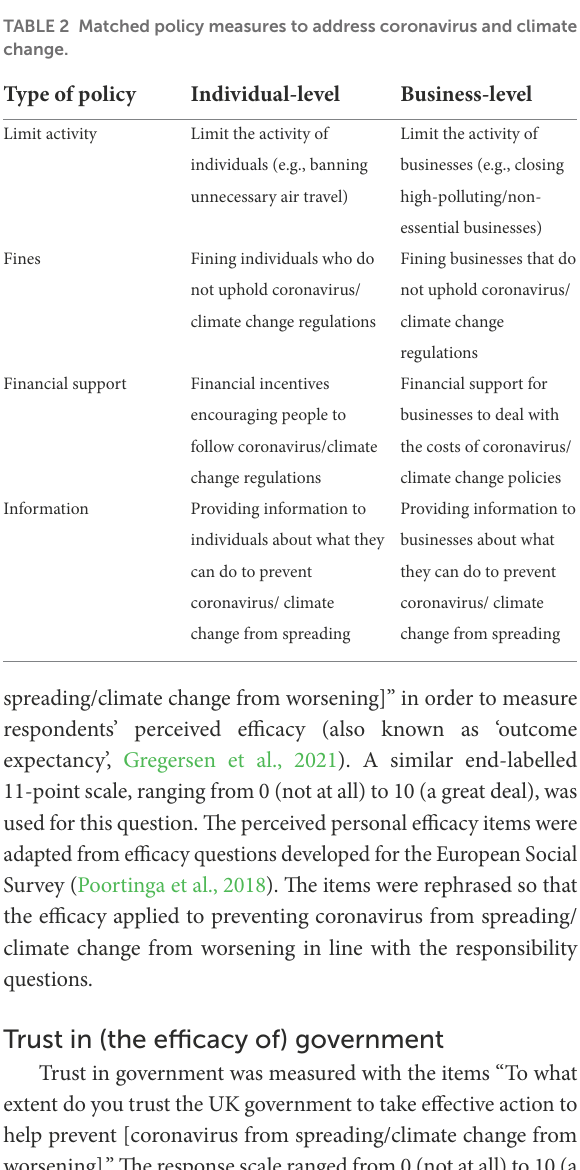
TABLE 1 . Characteristics of the sample ( N = 1,518).